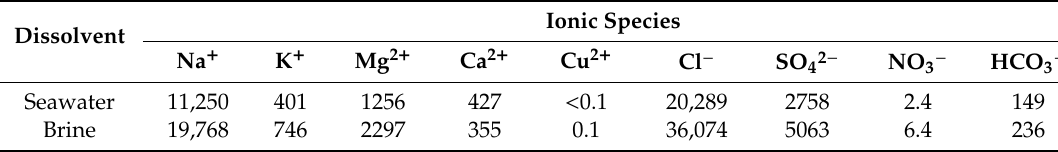
Table 3. Compositions of seawater and brine used in this study (mg /